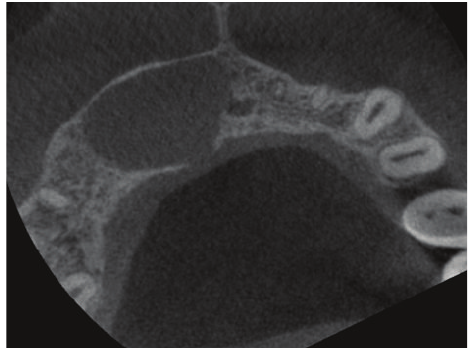
Figure 31: Pre-operative CBCT image in axial plane.